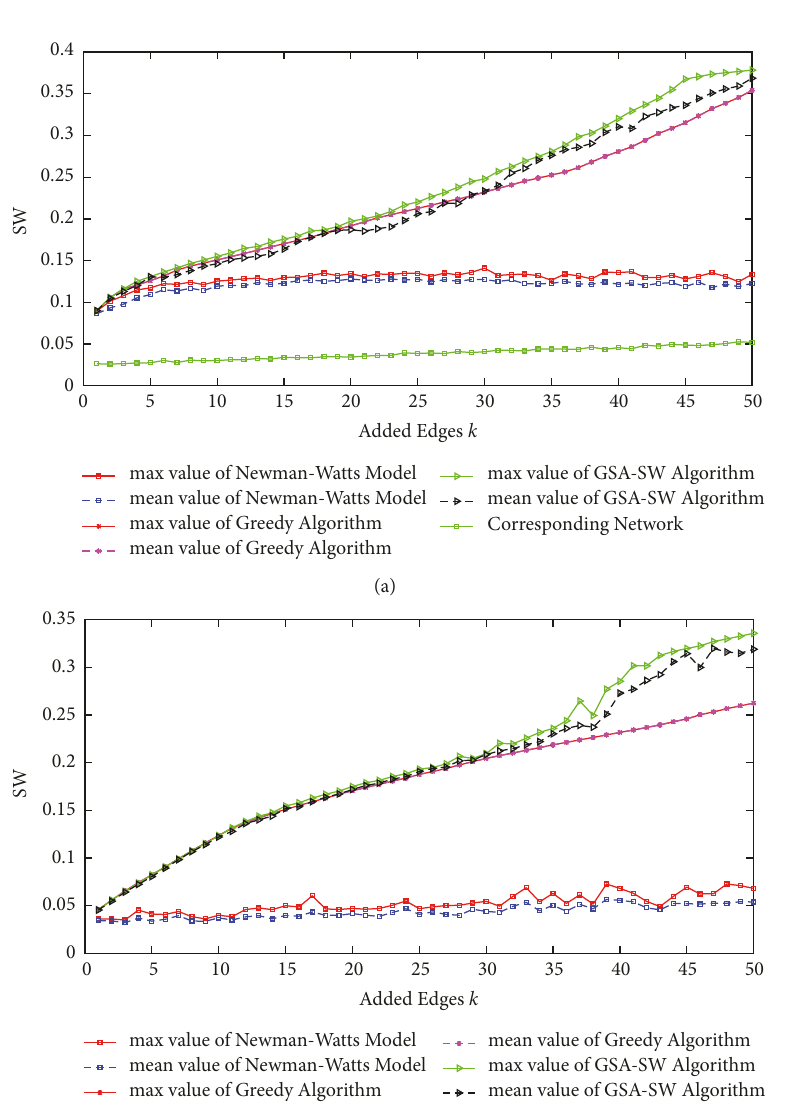
Figure 4: Optimizing results for improving efficiencyof transforming other networks to small-world networks. The figuresshow small-world property for three algorithms. (a) shows the results of small-world property optimization on a regular network. The results of corresponding network compute the average value SW after 100 times by reconnecting all the edges randomly on a regular network. (b) shows the results of small-world property optimization on a random network. Since the results of the six runs of the greedy algorithm are the same, the max and mean values of the greedy algorithm